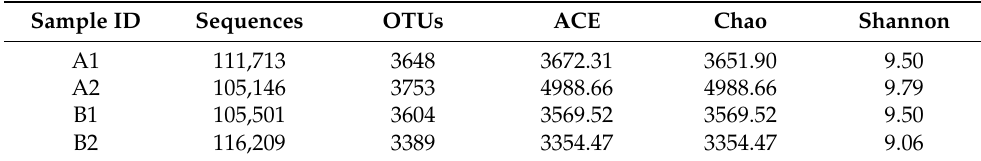
Table 1. Bacterial diversity of sample A1, A2, B1 and B2.